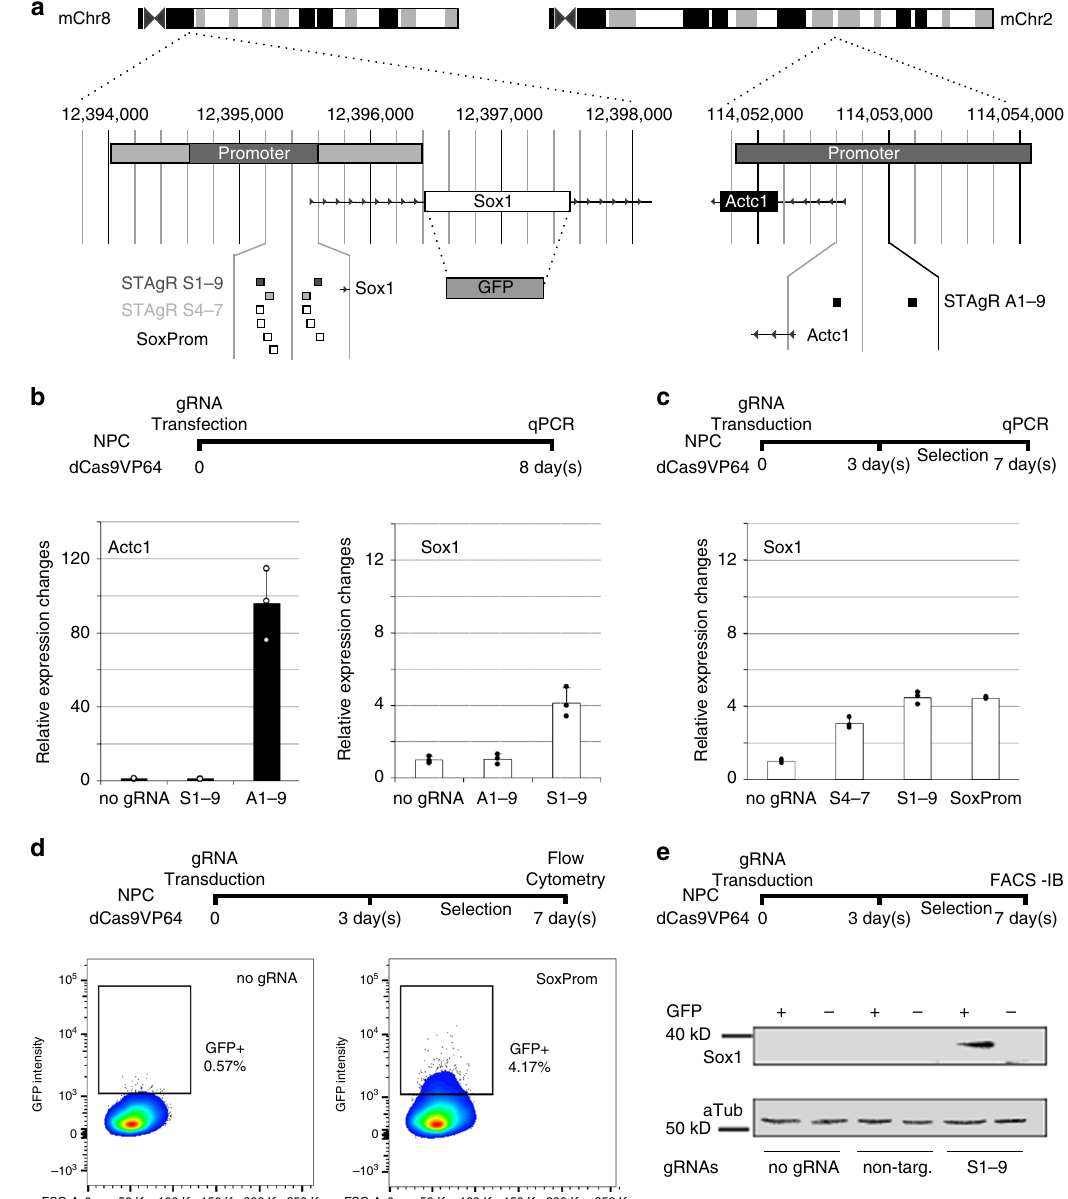
Fig. 1 Transcriptional editing of Sox1 leads to gene induction. a Schematic overview of the Sox1 and Actc1 locus in NPCs. Heterozygous knock-in of GFP into the Sox1 -ORF and gRNA targets are shown. b Moderate upregulation of Sox1 compared to Actc1 . gRNAs were transfected separately into NPCs. mRNA of Actc1 and Sox1 was quanti fi ed using qRT-PCR, and NPCs without transfection were used as a control population (no gRNA). Non-targeted loci were quanti fi ed as a control for unspeci fi c effects. Actc1 mRNA upregulation is signi fi cantly higher than Sox1 mRNA upregulation (two-sided Student ’ s t -test, p < 0.005). Data shown as the mean and standard error of the mean; n = 3 biological replicates (generated independently on different days in different clonal lines). c Alteration of gRNA sequences and positions does not signi fi cantly affect the ef fi ciency of transcriptional engineering. Three different gRNA lentiviruses were transduced and cells were selected for gRNA expression. Data shown as the mean and standard error of the mean; n = 3 biological replicates (generated independently on different days in different clonal lines). d Flow cytometry reveals that a small population of cells is responsive to transcriptional engineering. SoxProm gRNAs were transduced into Sox1 GFP NPCs, and cells were selected for gRNA expression. Flow analysis of cells reveals that a minority of cells respond to transcriptional activation with induced with GFP fl uorescence. e High Sox1 GFP levels correlate to high Sox1 protein levels. Sox1 GFP -positive and -negative cells were sorted from control populations (with either no gRNAs or non-targeting gRNAs) and activated populations, respectively. Western Blot reveales signi fi cantly higher Sox1 protein levels in the GFP-positive population from NPCs transduced with the SoxProm gRNAs only. Shown is one biological replicate; Image cropped for